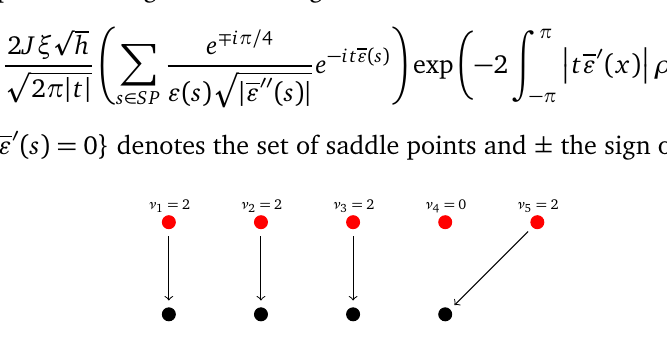
Figure 7: Sketch of the leading configurations contributing to M = N + 1 and k =